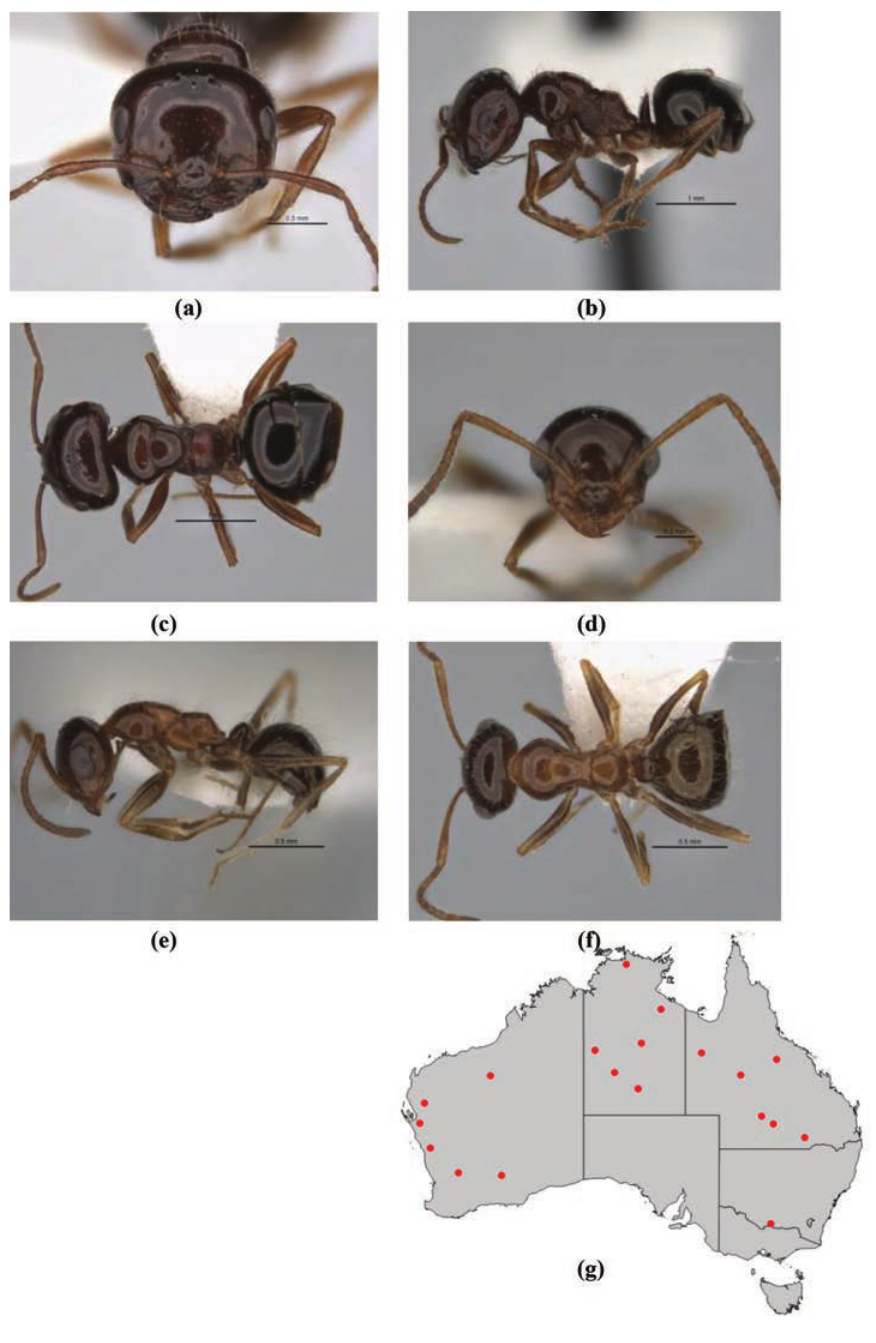
Figure 52. Melophorus ankylochaetes sp. n.: major worker paratype (JDM32-004761) frons ( a ), pro- file ( b ) and dorsum ( c ); minor worker holotype (JDM32-001990) frons ( d ), profile ( e ) and dorsum ( f ); distribution map for the species ( g ). Low resolution scale bars: 1 mm ( b, c ); 0.5 mm ( a, e, f ); 0.2 mm ( d